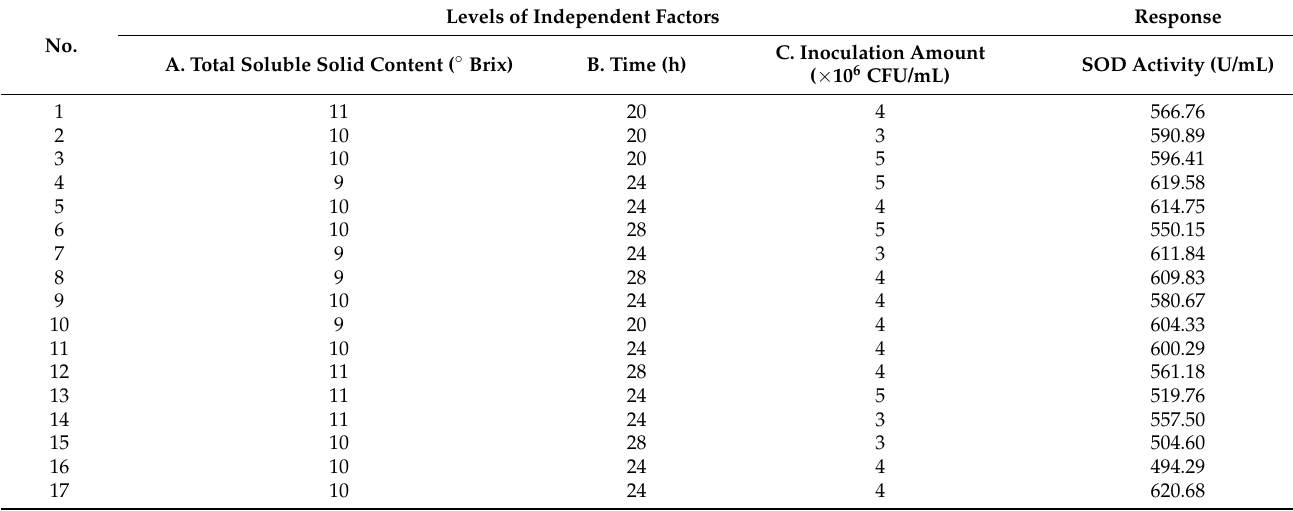
Table 5. The experiments and results of response surface optimization of the CFJ fermentation